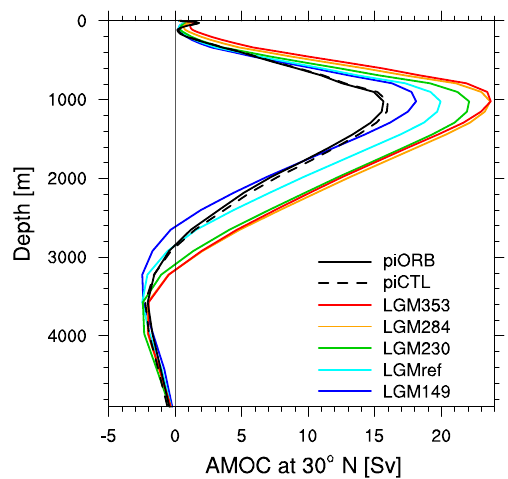
Figure 7. Profile of the AMOC at 30 ◦ N for the different exper- iments. Experiments with LGM setup are shown in colour, and piCTL and piORB are shown in